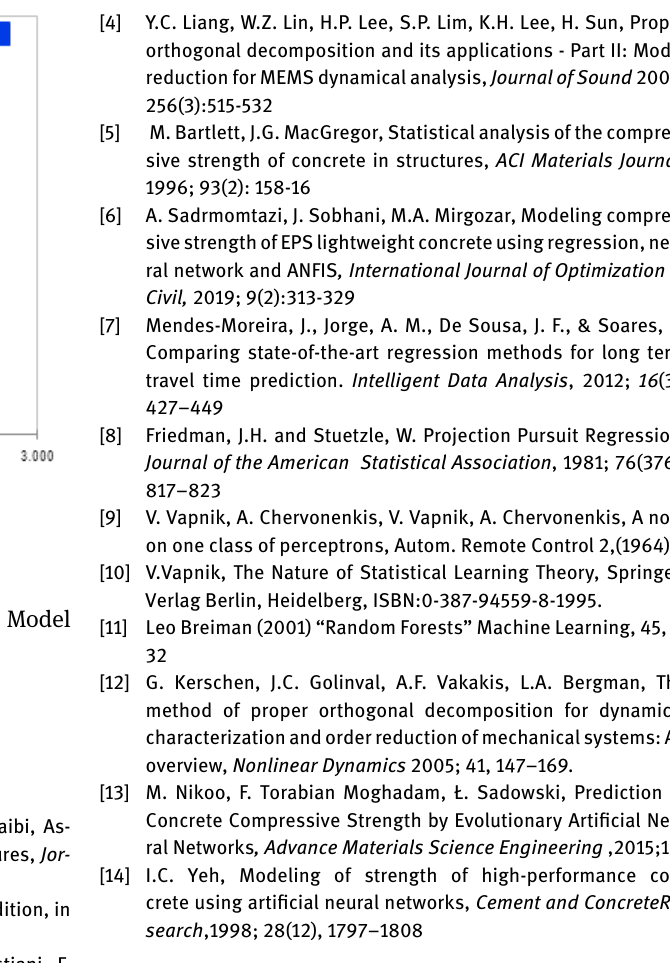
The equation of the model formalized as, Y Model (N/mm 2 ) = 2.738678+0.904492*Y Lab (= Yp-N/mm 2